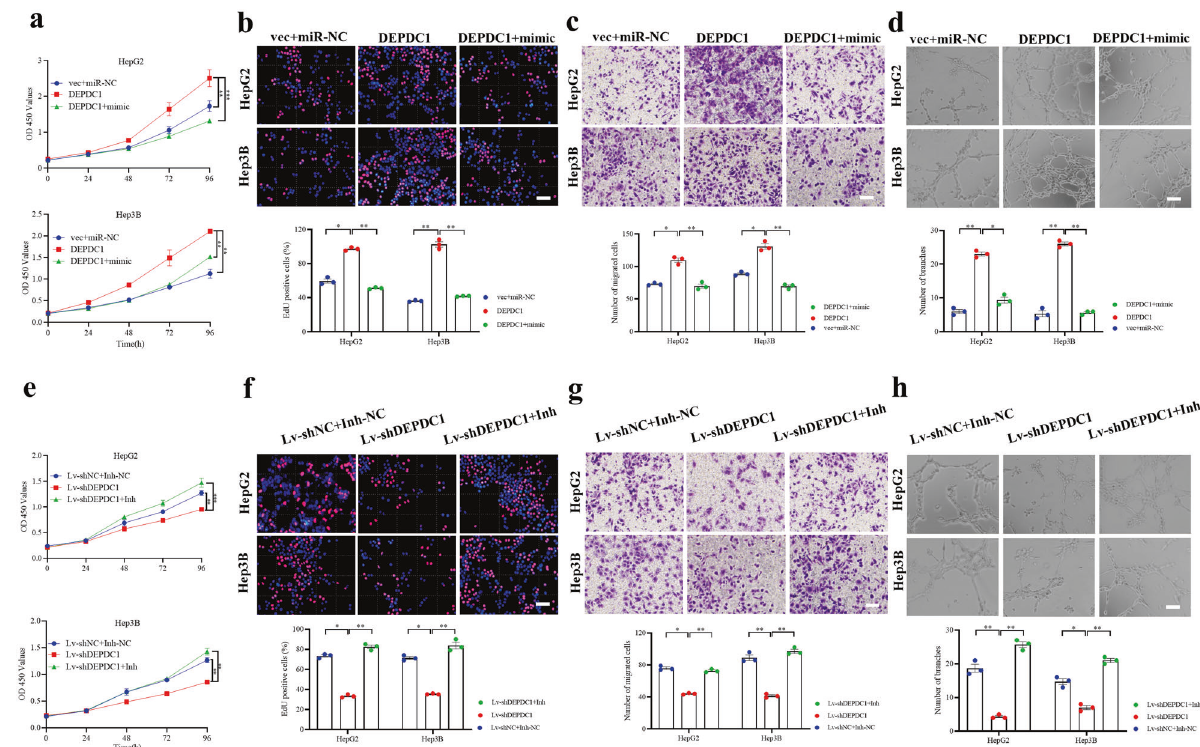
Fig. 4 DEPDC1 reinforces the progression and angiogenesis of HCC cells in vitro. a Cell proliferation was assessed daily for 4 days using the Cell Counting Kit-8 (CCK-8) assay in DEPDC1-overexpressing HepG2 and Hep3B cells. b EdU assays were performed to analyze the HepG2 and Hep3B cell proliferation in differently transfected groups. c Transwell assays were used to evaluate the involvement of DEPDC1 for invasion in DEPDC1-overexpressing HepG2 and Hep3B cells. d Effect of DEPDC1 expression in HepG2 and Hep3B cells on human umbilical vein endothelial cells (HUVECs) in tube formation assay. Each bar represents the mean values ± SD of three independent experiments. e , f Cell proliferation assessed in DEPDC1 knockdown HepG2 and Hep3B cells. g Transwell assays assessed in DEPDC1 knockdown HepG2 and Hep3B cells. h Tube formation assay assessed in DEPDC1 knockdown HepG2 and Hep3B cells. Data are shown as mean ± SD, n = 3. The data statistical signi fi cance is assessed by Student ’ s t test. * P < 0.05, ** P < 0.01, *** P < 0.001. Scale bars: 50 μ